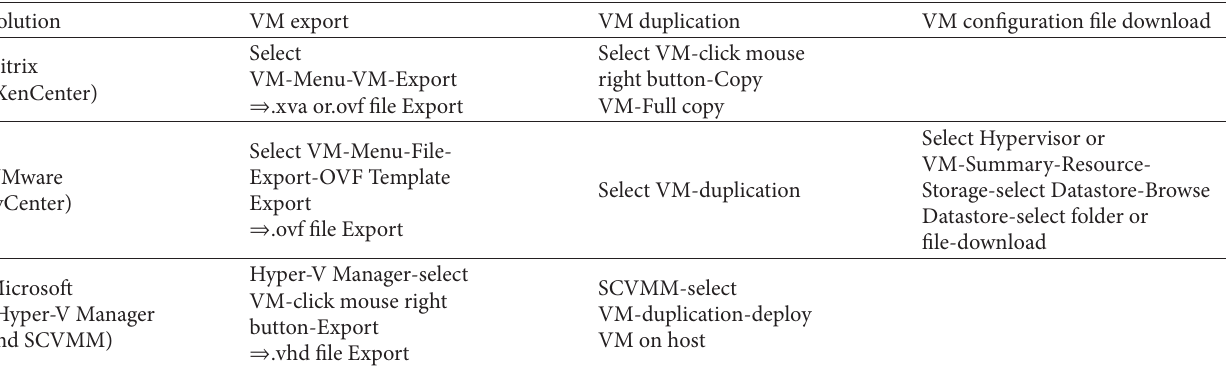
Table 8: Data acquisition method using the hypervisor management